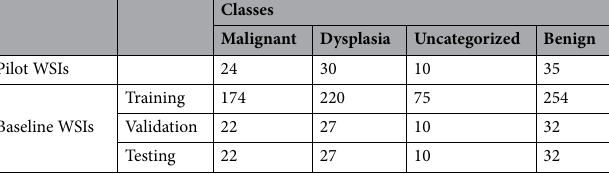
Table 2. Information about the number of stomach whole-slide images (WSIs) for each data split.